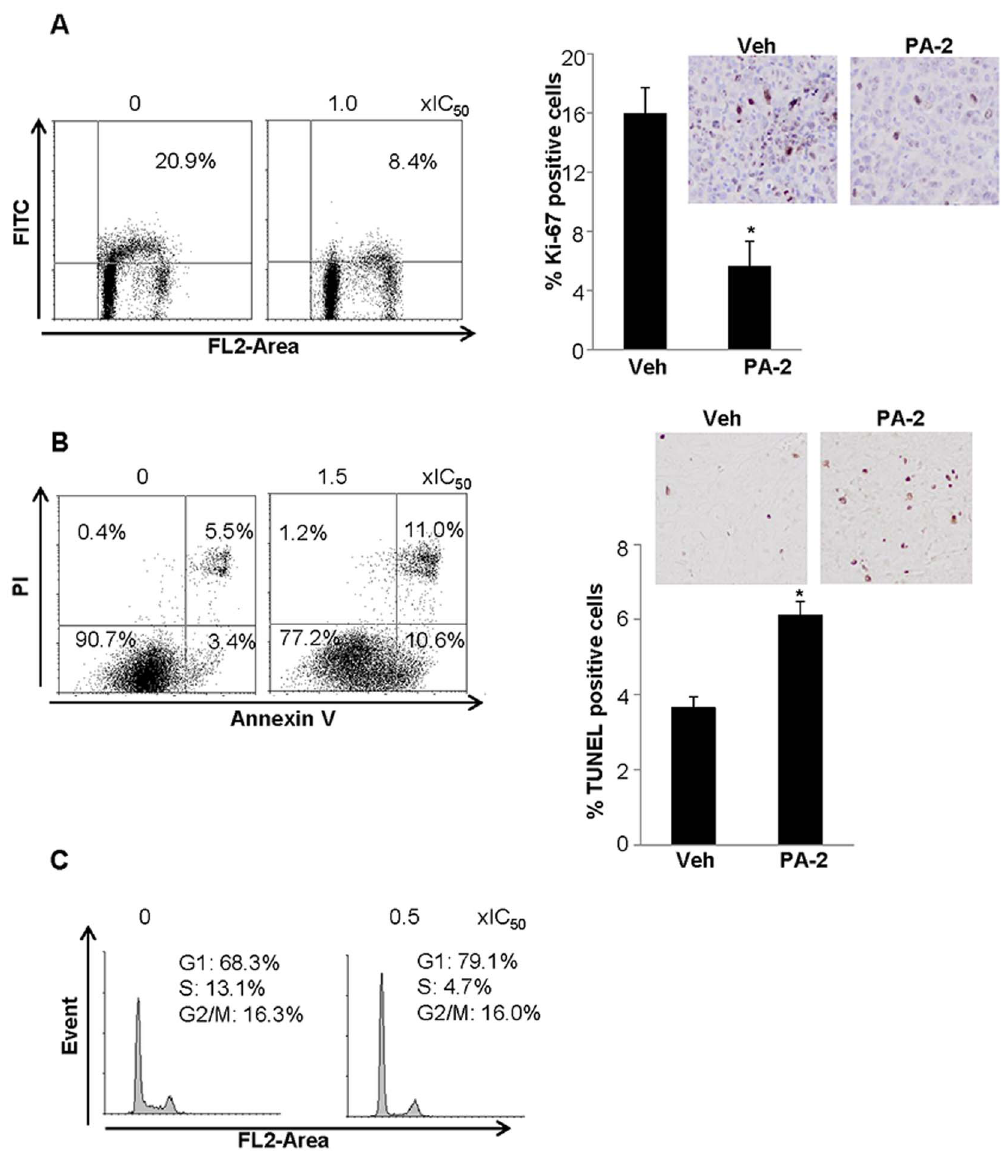
Figure 2. Phospho-aspirin-2 exerts a triple cytokinetic effect on MCF7 cells. A: Left : MCF7 cells were treated PA-2 for 24 h and the percentage of proliferating cells was determined by BrdU incorporation. Right : The percentage of proliferating cells in vehicle or PA-2 treated MCF7 xenografts were determined by Ki-67 staining. Representative images (top) and the quantification (bottom) of Ki-67 expression in tumor sections, * p , 0.007. B: Left : MCF7 cells treated with PA-2 for 24 h were stained with Annexin V/PI, and the percentage of apoptotic cells was determined by flow cytometry. Right : The percentage of apoptotic cells in MCF7 xenografts were determined by TUNEL assay. Representative images (top) and the quantification (bottom) of TUNEL positive cells in tumor sections, * p , 0.002. All values are mean 6 SEM. C: PA-2 blocks the G 1 /S cell cycle phase transition after 24 h treatment in MCF7 cells, determined by flow cytometry following PI staining.